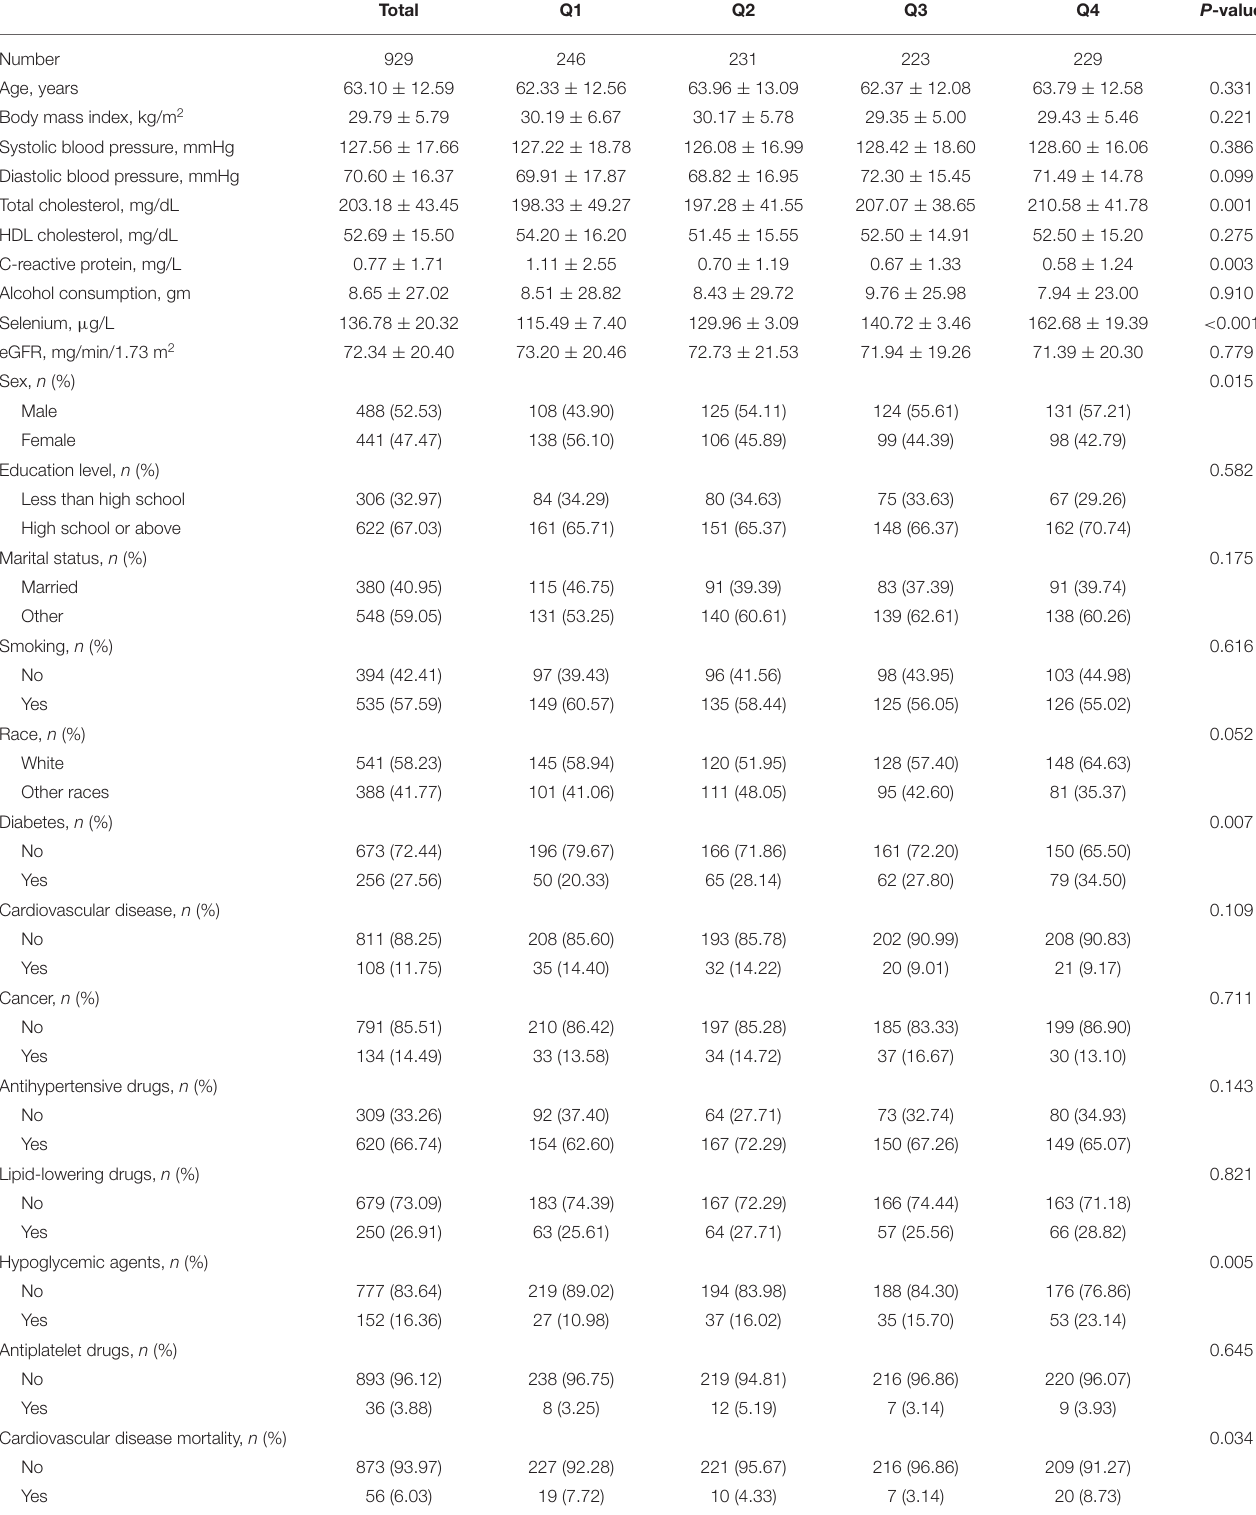
TABLE 1 | Baseline demographic and clinical parameters among participants by selenium